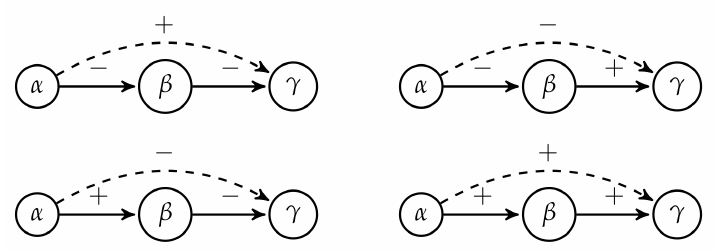
Figure 1. Sign rule for attacks and